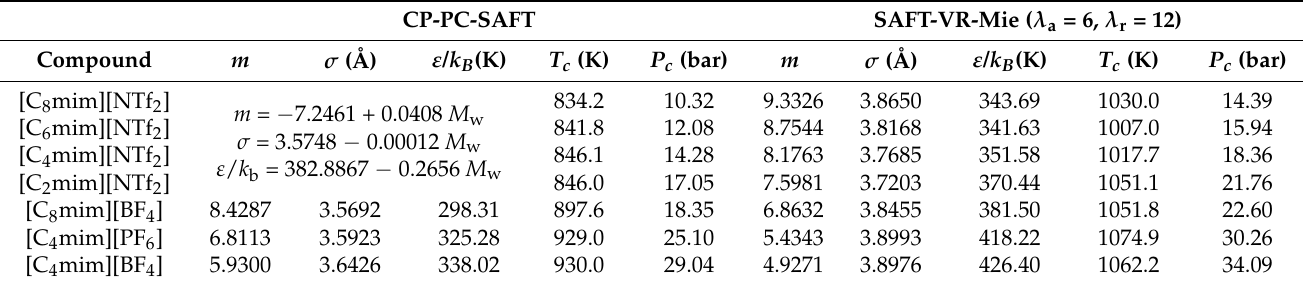
Table 2. The molecular parameters and critical constants of pure ILs yielded by SAFT-VR-Mie and CP-PC-SAFT [39,42]. CP-PC-SAFT